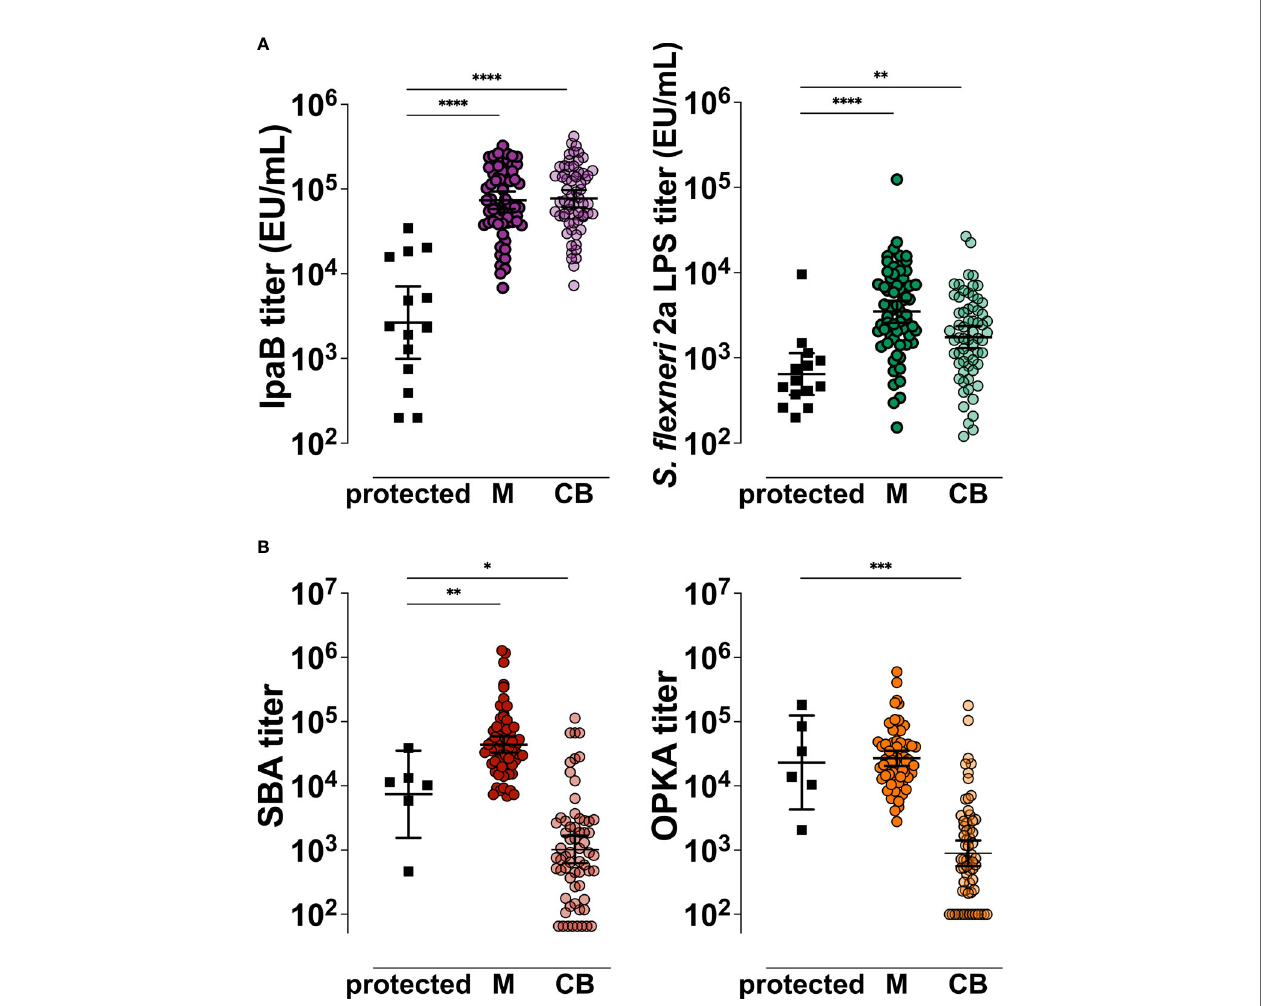
FIGURE 7 | Comparative analysis of Shigella antigen-speci fi c and functional antibody titers in the mother-infant dyad in relation to clinical protective thresholds. IpaB- and S. fl exneri 2a LPS-speci fi c (A) and S. fl exneri 2a functional (B) serum antibody titers measured pre-challenge in North American volunteers (black squares, protected) that remained healthy or had mild disease after wild-type S. fl exneri 2a infection and in Malawi maternal (M) or cord blood (CB) sera. Symbols represent individual titers. Differences between groups were determined by paired t-test; P > 0.05, * P < 0.05, ** P < 0.01, *** P < 0.001, **** P <